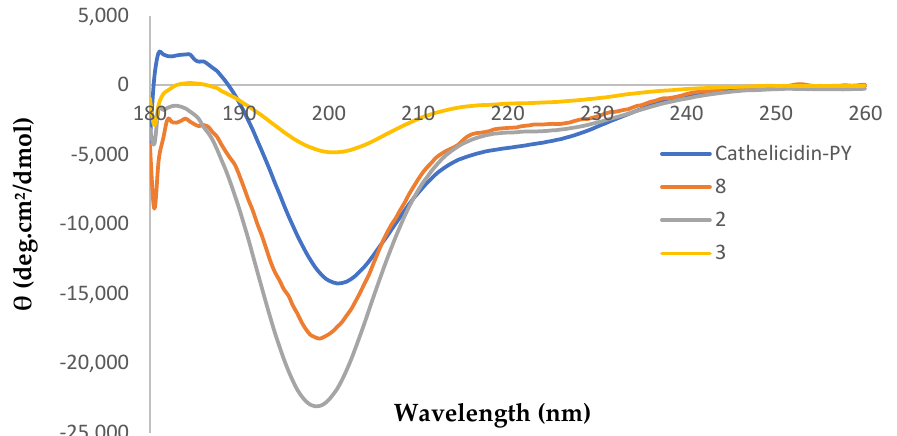
Figure 4. Circular dichroism (CD) spectra carried out in water for cathelicidin − PY and associated analogues, 2 , 3 , and 8 , depicting a random coil conformation. CD spectra were collected at 25 °C with peptides dissolved at 0.2 mM in pH 7.4 phosphate buffer (20 mM).